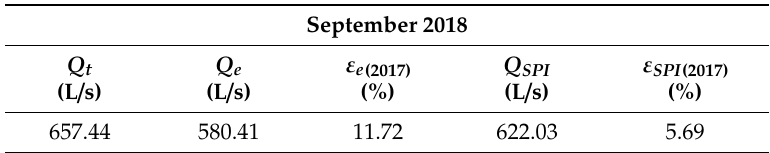
Table 3. Comparison between total spring minimum discharge ( Q t ), estimated minimum discharge ( Q e ) and estimated minimum discharge with the SPI index ( Q SPI